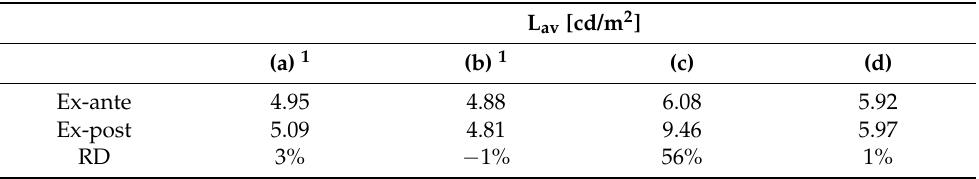
Table 19. Observation point I1: (a) Cassero Façade, (b) Cassero tower, (c) residential building, (d) horizontal floor.